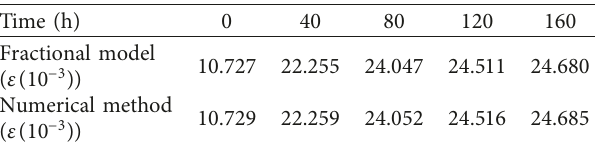
Figure 6: Fractional model solution and numerical method Table 2: Partial data of the fractional model solution and numerical method solution.